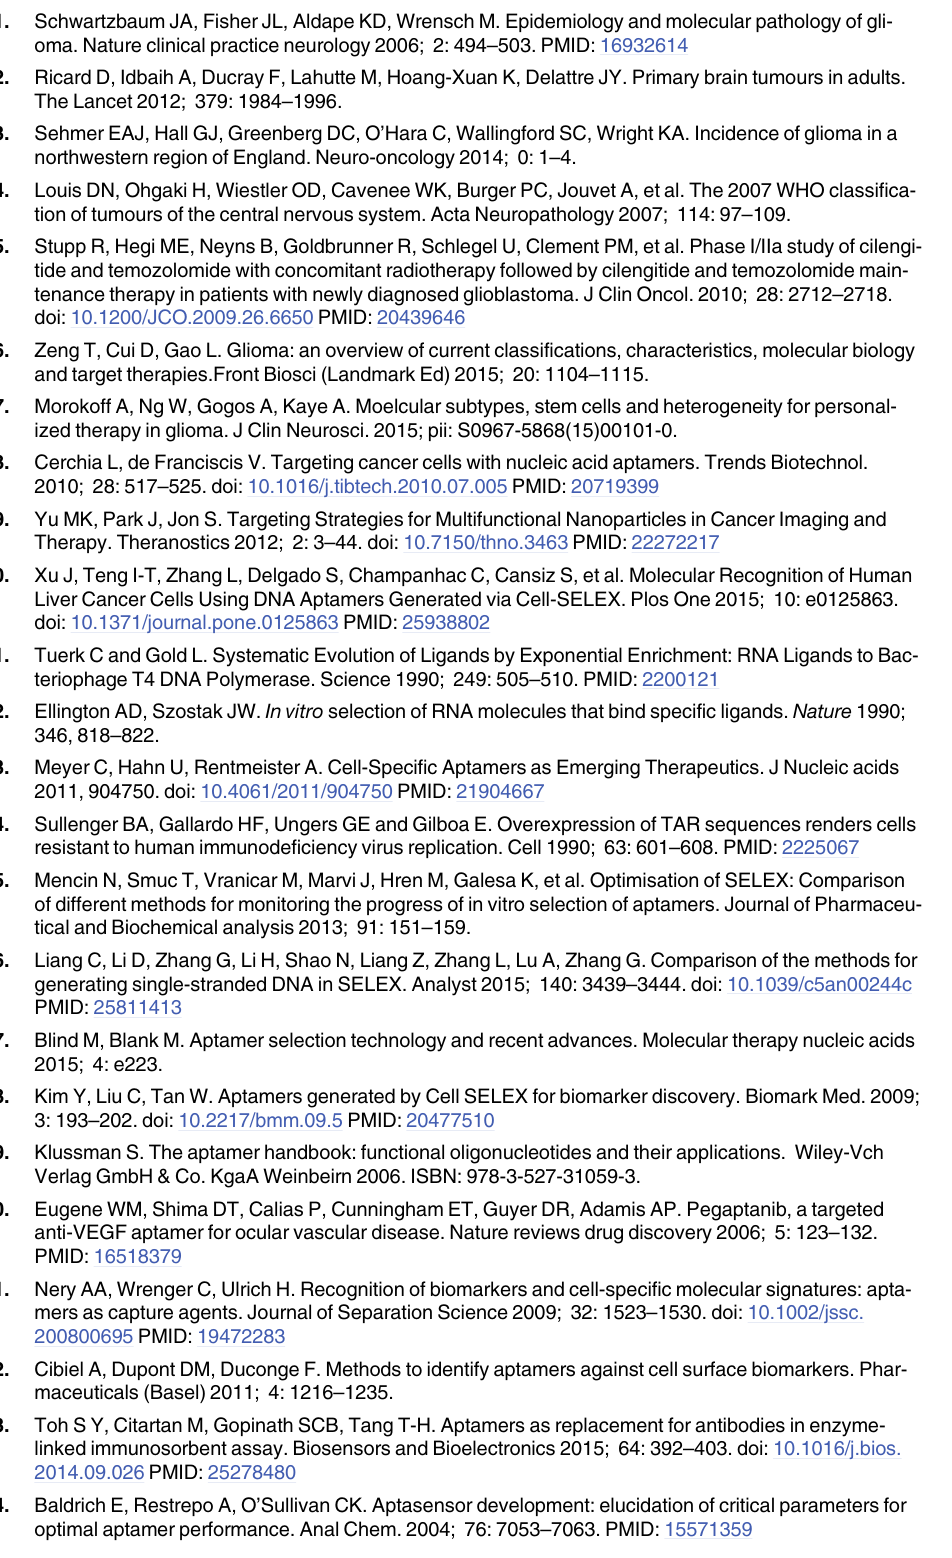
PLOS ONE | DOI:10.1371/journal.pone.0134957 August 7,